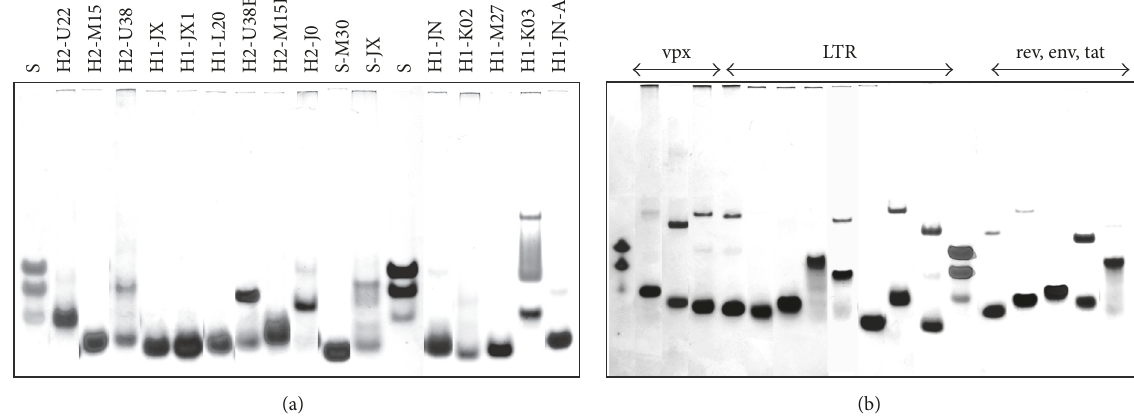
Figure 6: Molecular standard S, the mix of d(AC) 9 , d(AC) 14 , and d(AC) 18 , was used. Electrophoretic separation was performed in a 14% polyacrylamide gel at 10 ∘ C in 25 mM Britton-Robinson buffer (pH 7.0) and 50 mM KCl at 8 ∘ C in (a) and 50 mM NaCl in (b). Prior to being used, the DNA sample was heated in the same buffer for 5min at ∼ 98 ∘ C and slowly cooled to room temperature within 30 min. Table 1: Melting temperatures and molecularities of the studied DNA oligonucleotides in the presence of 50 mM sodium and potassium ions. Potassium Sodium Oligo.